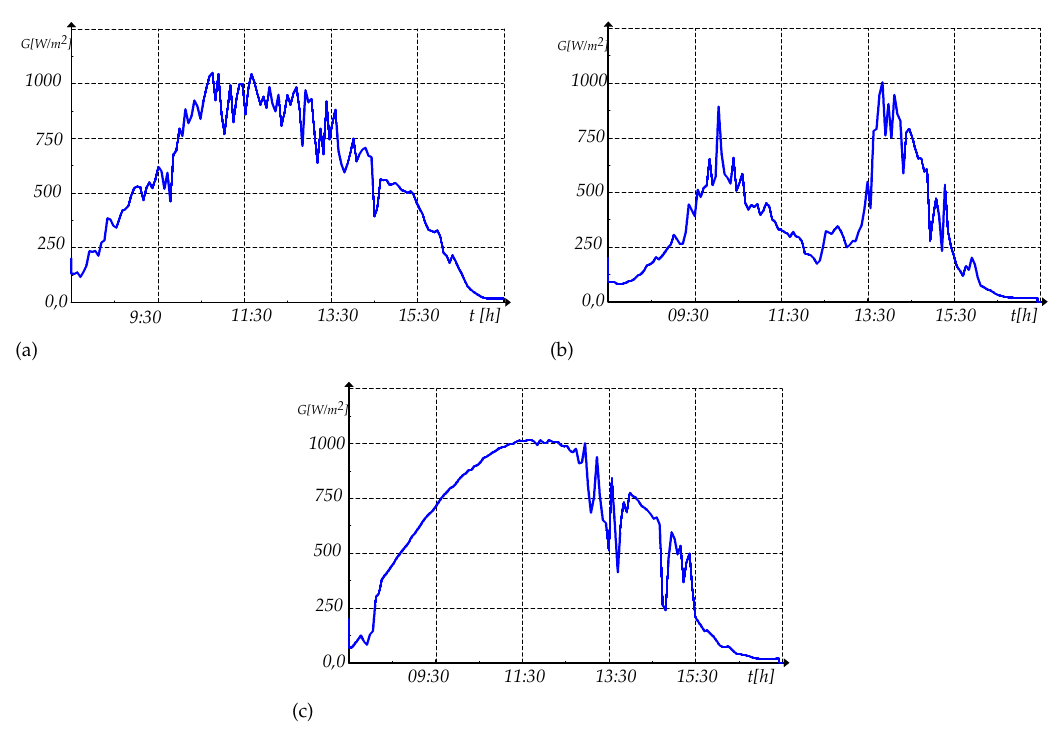
Figure 20. Solar irradiance data ( a ) Day 1 ( b ) Day 2, and ( c ) Day